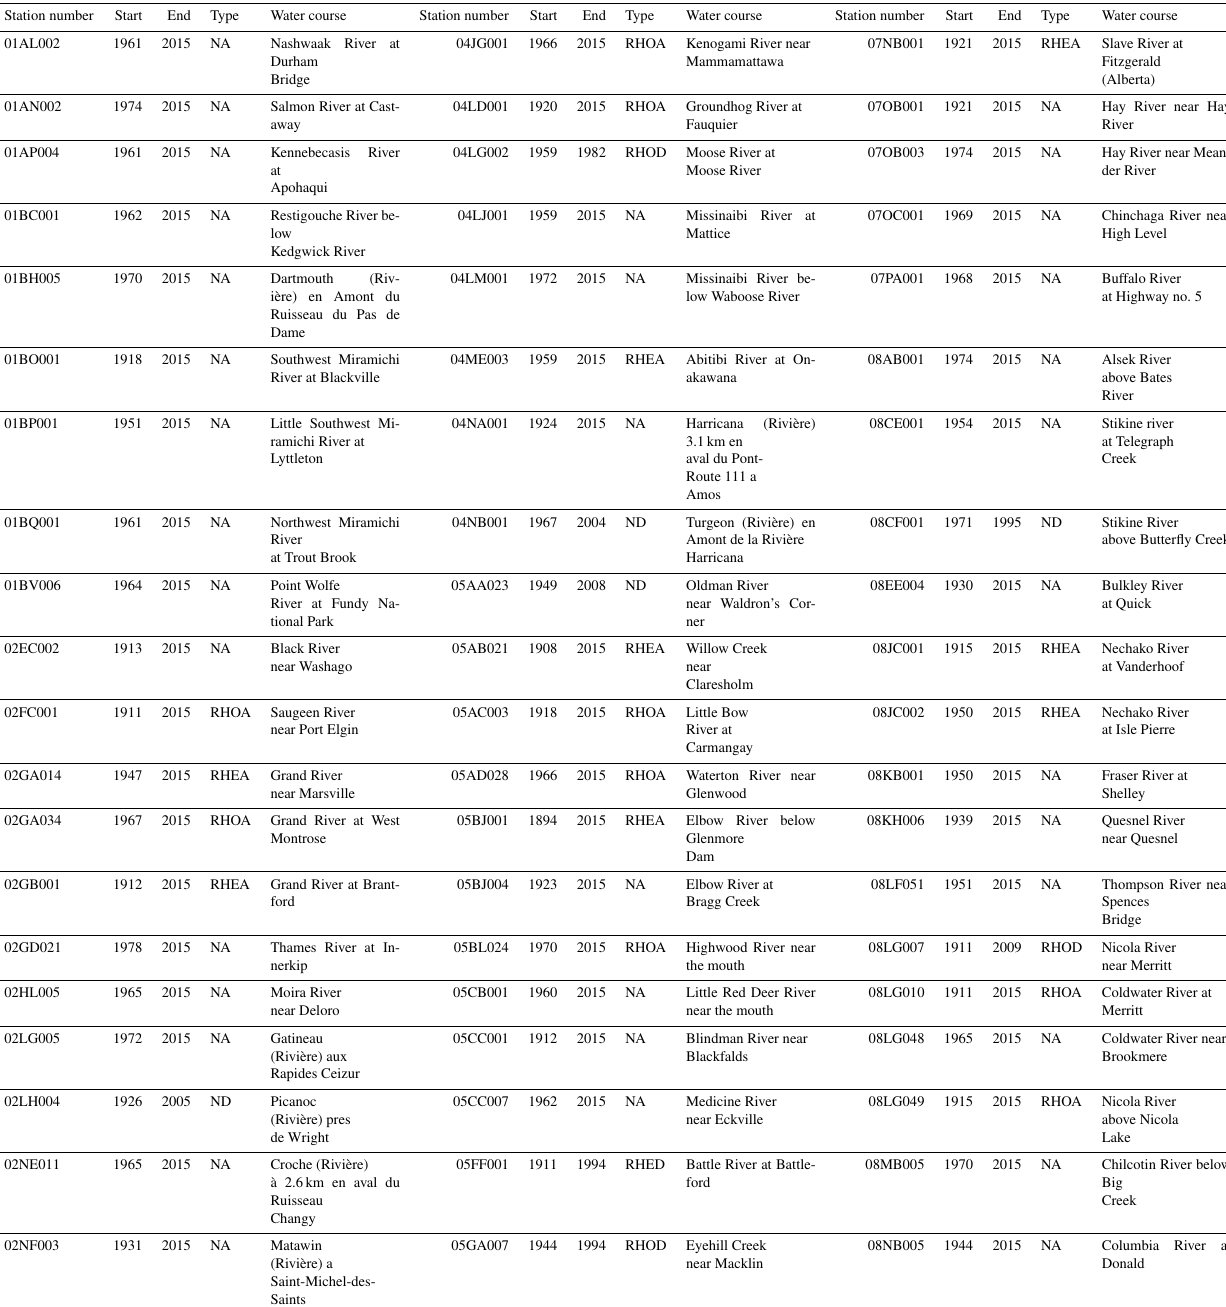
Table A1. List of the 196 National Hydrometric Program stations that comprise the Canadian River Ice Database. Data extraction time period are shown in the “start” and “end” columns. Locations with “rivière” in the name of the water course are in Quebec. The “type” column is the regime type, defined as follows: natural, active (NA); natural, discontinued (ND); regulated, heterogeneous, active (RHEA); regulated, heterogeneous, discontinued (RHED); regulated, homogeneous, active (RHOA); regulated, homogeneous discontinued